Question: Provide a one-line summary of what is displayed.
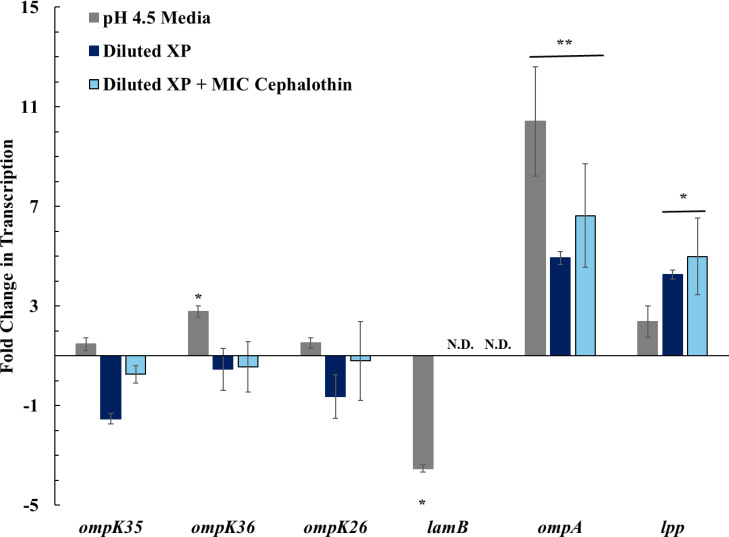
Answer: Transcription of outer membrane porins is altered by low pH and Xperience treatment. Transcription of six outer membrane porins was determined by qPCR. Relative transcriptional levels were determined using the ΔΔCt method comparing against the housekeeping gene gapA and the untreated growth strain. N = 3 independent assays. Bars represent the standard error from the mean. Statistical comparisons were conducted using ΔCt values to allow for comparison relative to the expression of each gene in untreated (neutral LB) culture. * P < 0.05, ** P < 0.005, *** P < 0.0001. N.D. indicated not detected above thresholds for the assay.